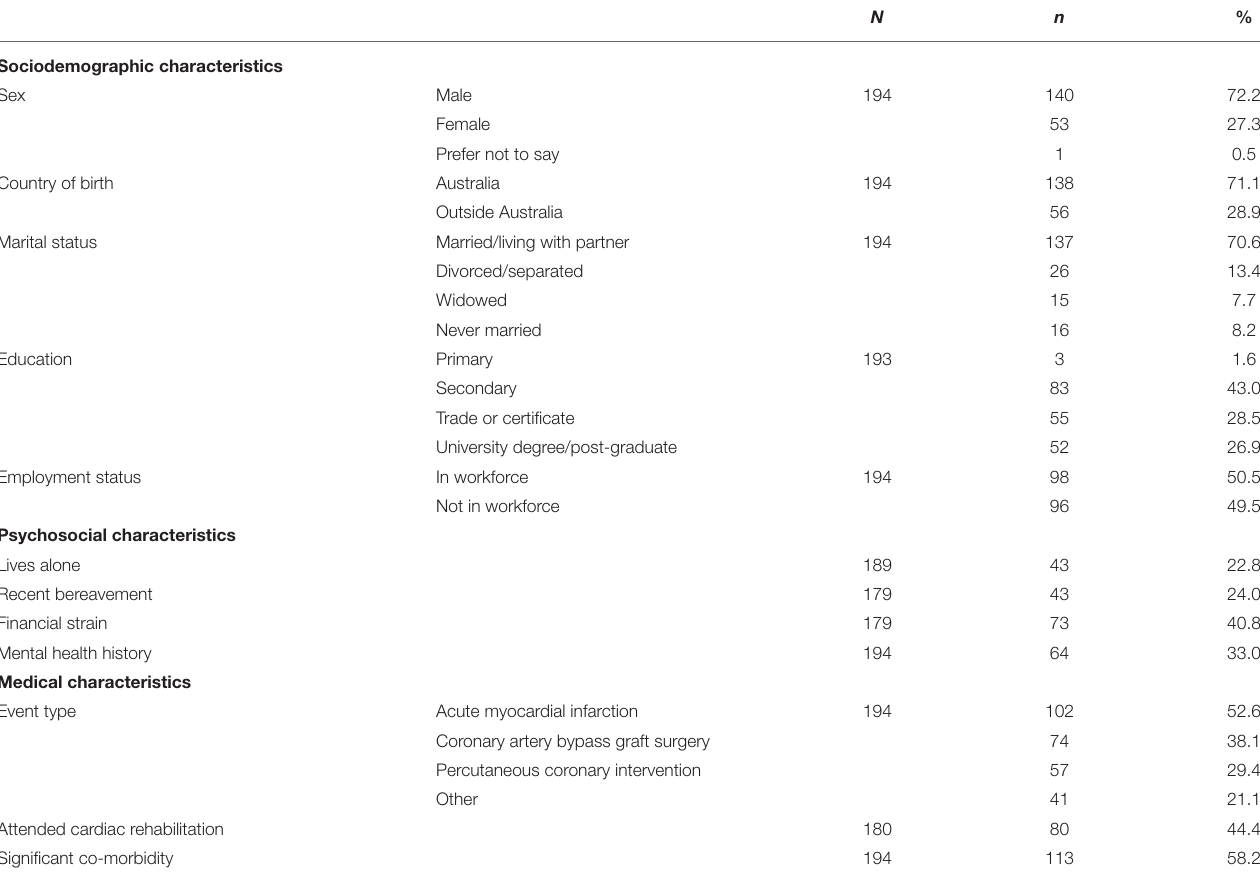
TABLE 1 | Characteristics of